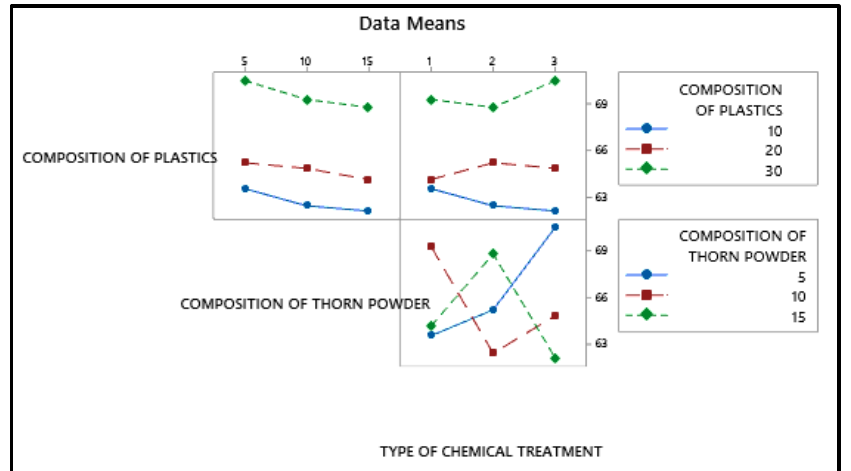
Figure 10. Effects graph for tensile strength.